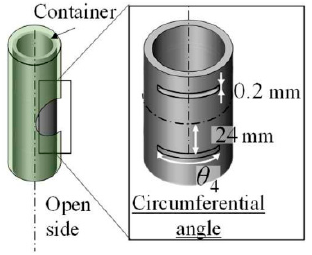
Figure 10. Size and position of slits.